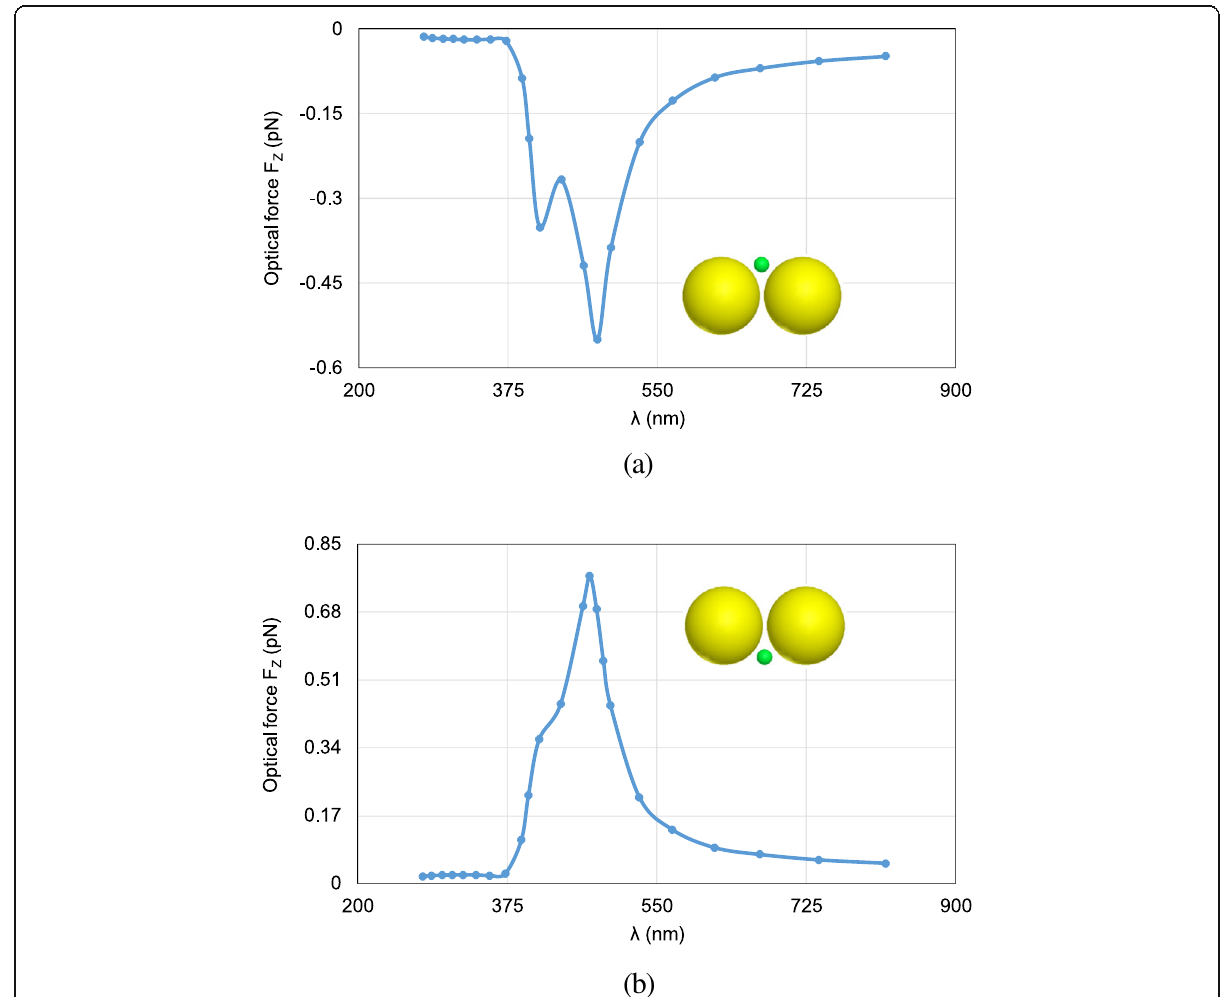
Fig. 6 Calculated results of optical forces exerted on the nanosphere in the system of gold nanosphere dimer, varying with the wavelength λ of incident light. a The object nanosphere is located at (0, 0, 20nm). b The object nanosphere is located at (0, 0, −